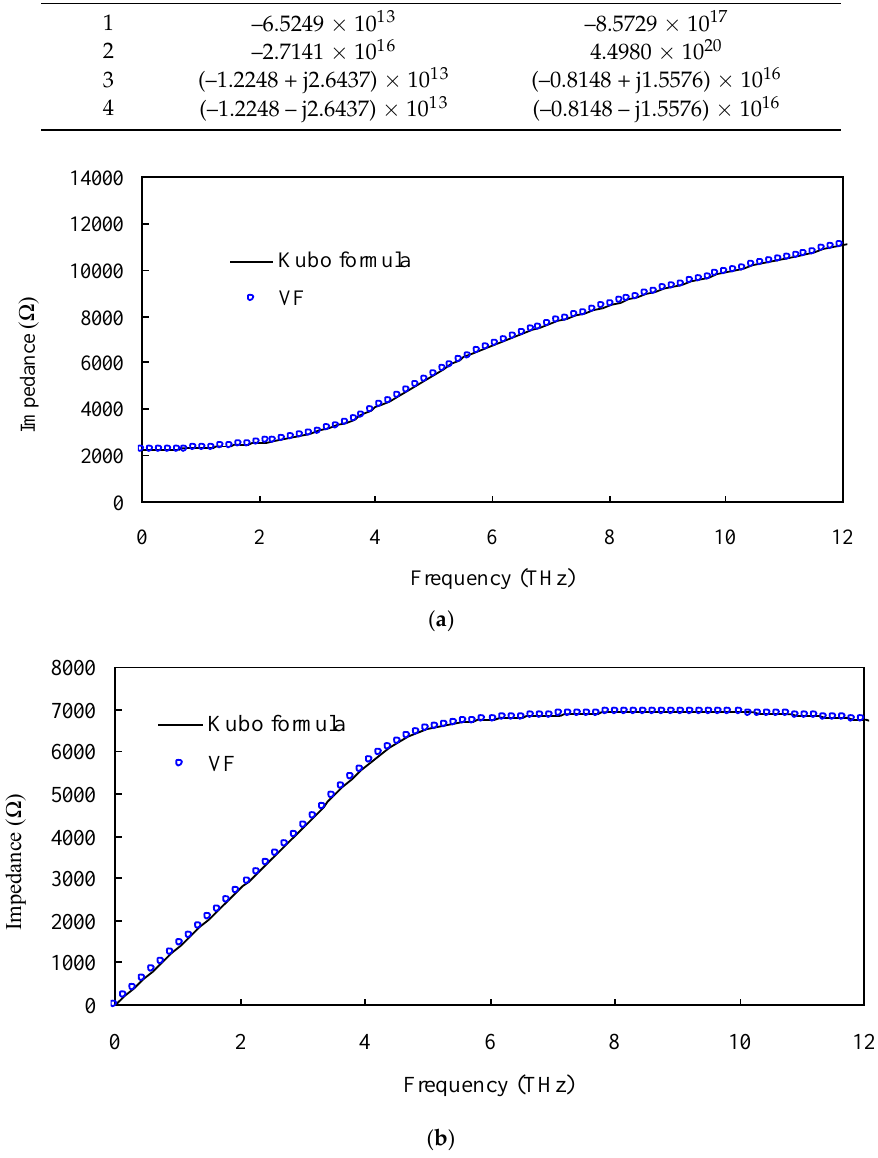
Figure 4. Graphene’s surface impedance: ( a ) real parts; ( b ) imaginary parts.